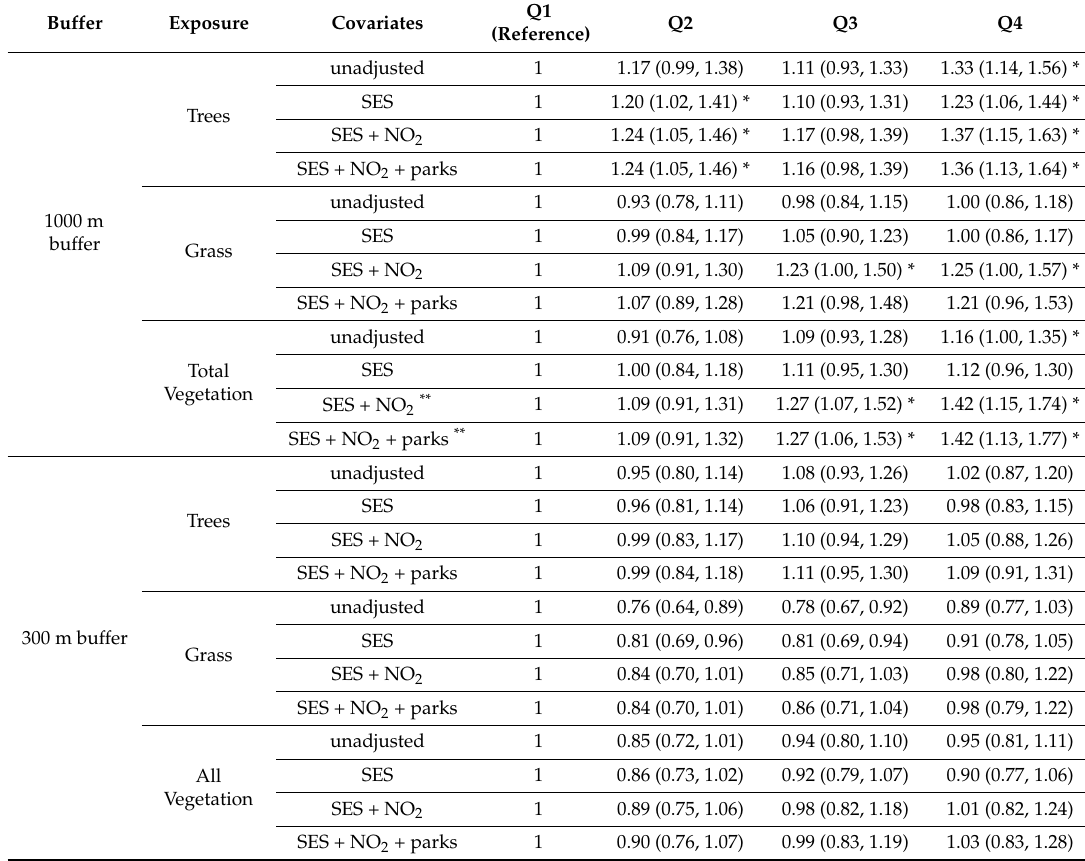
Table 3. Relative risks (RRs) for self-reported “very good” or “excellent” health by quartile of vegetation